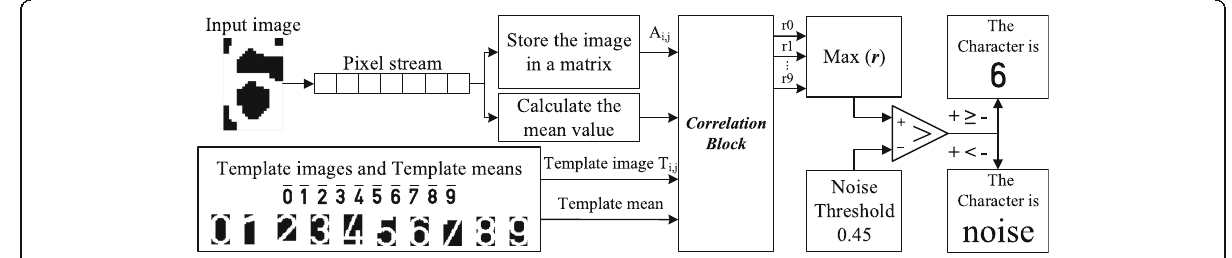
Fig. 8 First approach OCR hardware implementation block